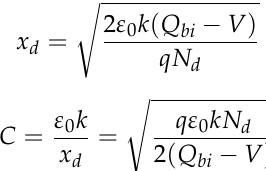
Figure 6 are insulators (green region in Figure 8d), they are not suitable for the Schottky electrode contact model. Their k values are in the range of 10.5~55.4, which is in between two sublayers. In order to further confirm the mechanism for the huge dielectric